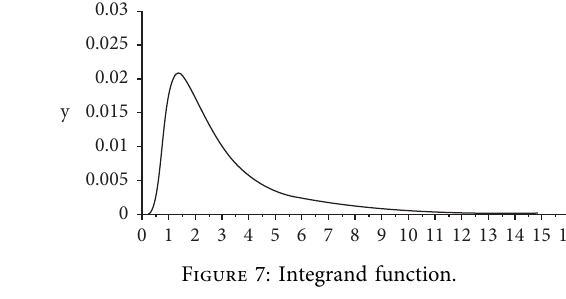
Figure 7: Integrand function.